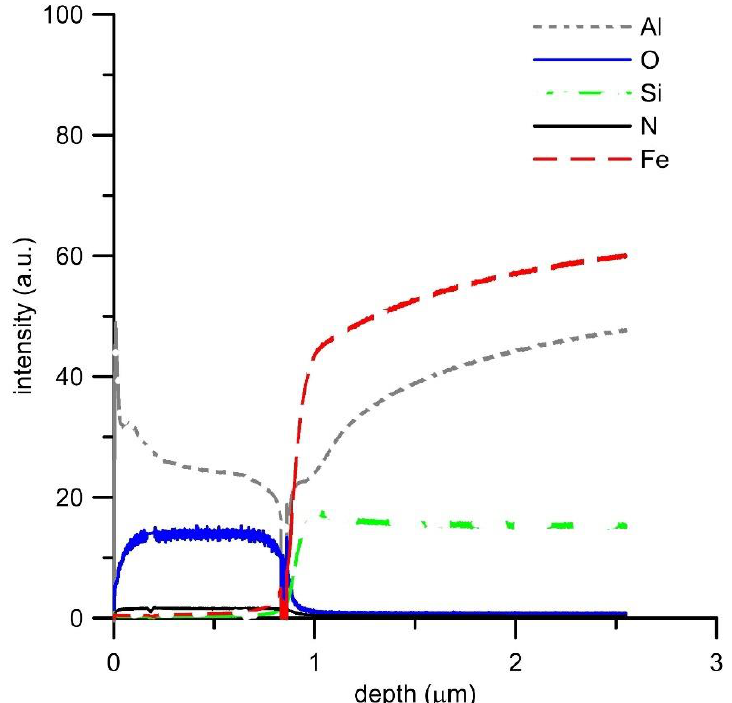
Figure 9. GDOES depth profile of oxidized FeAl20Si20 alloy.